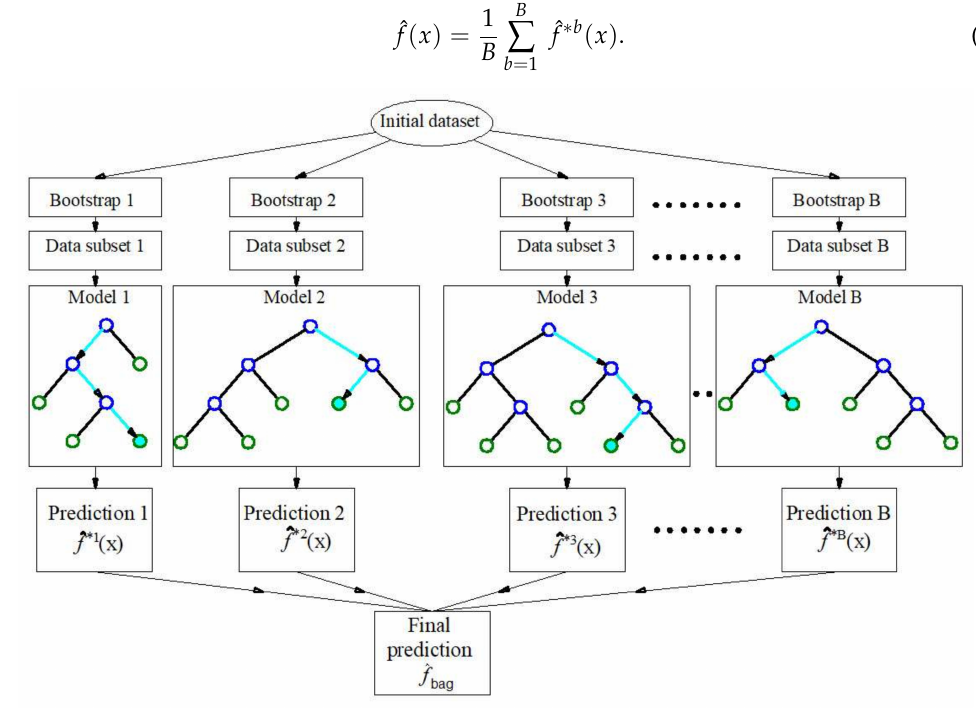
Figure 5. Bootstrap aggregation (bagging) in regression tree ensembles